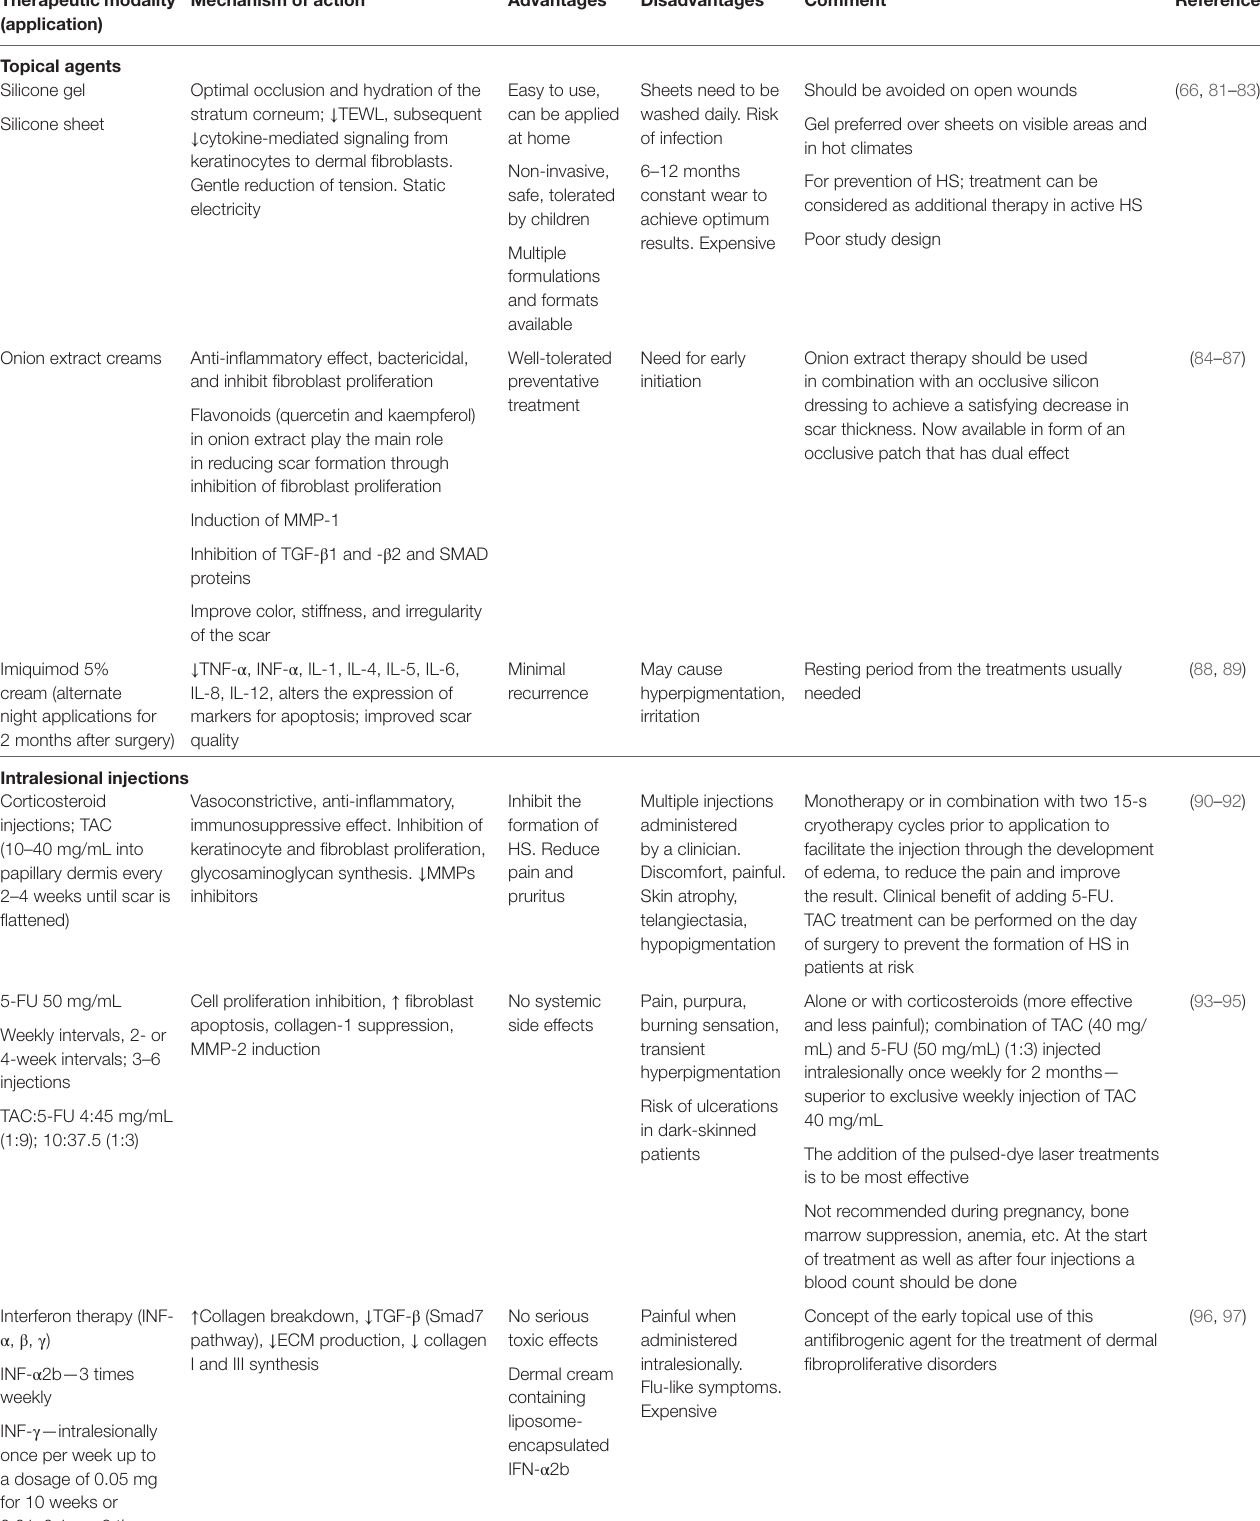
TABLe 2 | Treatment options for hypertrophic